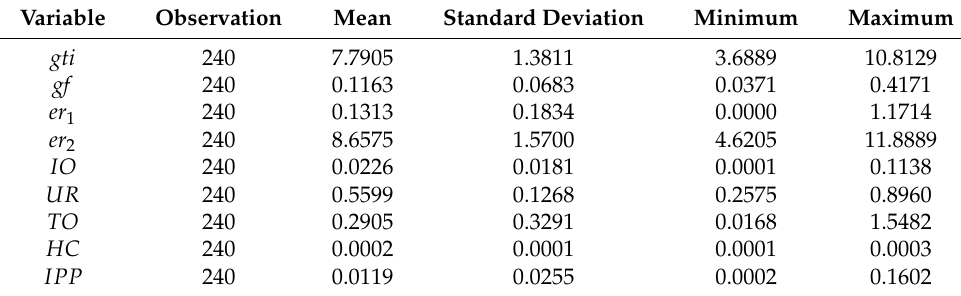
Table 1. Descriptive statistics of the variables.